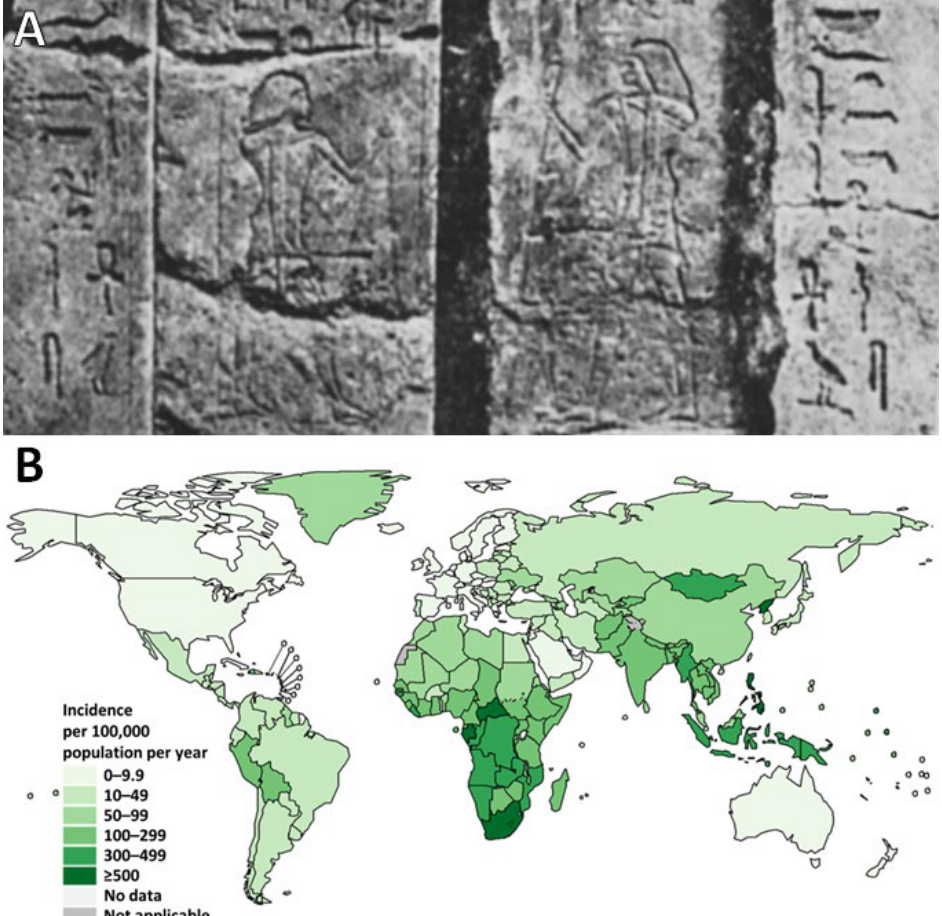
Figure 1. ( A ) Engravings on the doors of an Egyptian tomb depicting individuals suffering from tuberculosis (TB). The arm is exaggeratedly contorted to emphasize the deformity. Adapted from reference [6], copyright (2022) by Copyright Clearance Center, with permission from Elsevier. ( B ) Estimated TB incidence rates over the world in 2021. Adapted from reference [9], used under Crea- tive Commons BY-NC-SA 3.0 IGO license.